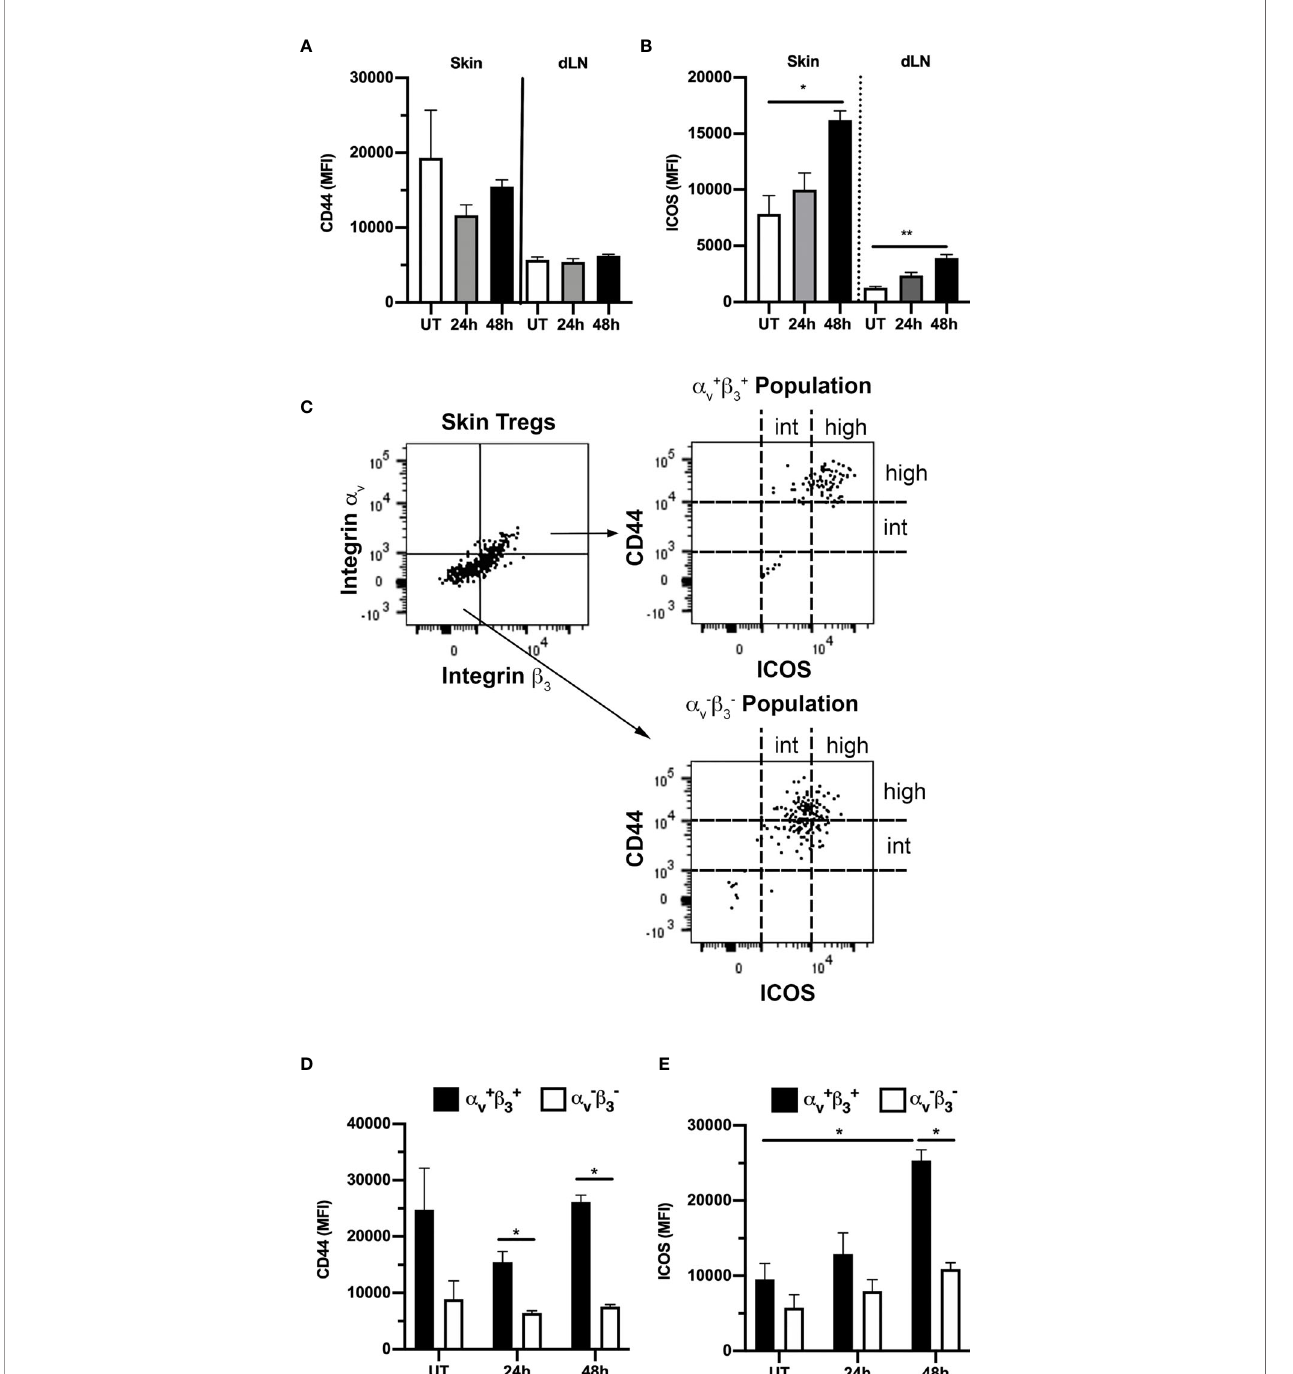
FIGURE 7 | a v b 3+ Tregs in skin have a highly-activated phenotype. Expression of activation markers CD44 and ICOS on Tregs from skin and draining lymph nodes (dLN) of untreated (UT) mice, and 24 and 48 h post CS induction was assessed using fl ow cytometry. (A, B) Expression (MFI) of CD44 (A) and ICOS (B) on all Tregs, shown for both skin and dLN-derived cells in UT mice, and 24 and 48 h post CS-induction. (C – E) Comparison of expression of CD44 and ICOS on a v + b 3 + and a v- b 3- Tregs. (C) Representative fl ow cytometry dot plots showing gating used to de fi ne a v+ b 3+ and a v- b 3- Treg populations (left panel) from skin Tregs of an UT mouse, and CD44/ICOS expression on the two populations (right hand panels). (D, E) Quantitation of CD44 (D) and ICOS (E) expression (MFI) on a v+ b 3+ and a v- b 3- skin Tregs from UT mice, and 24 and 48 h post CS induction. Data are shown as mean ± SEM derived from 4 mice/group. Data were evaluated via Kruskal-Wallis test with Dunn ’ s multiple comparison tests between all timepoints. * p < 0.05, ** p < 0.01 for the comparisons